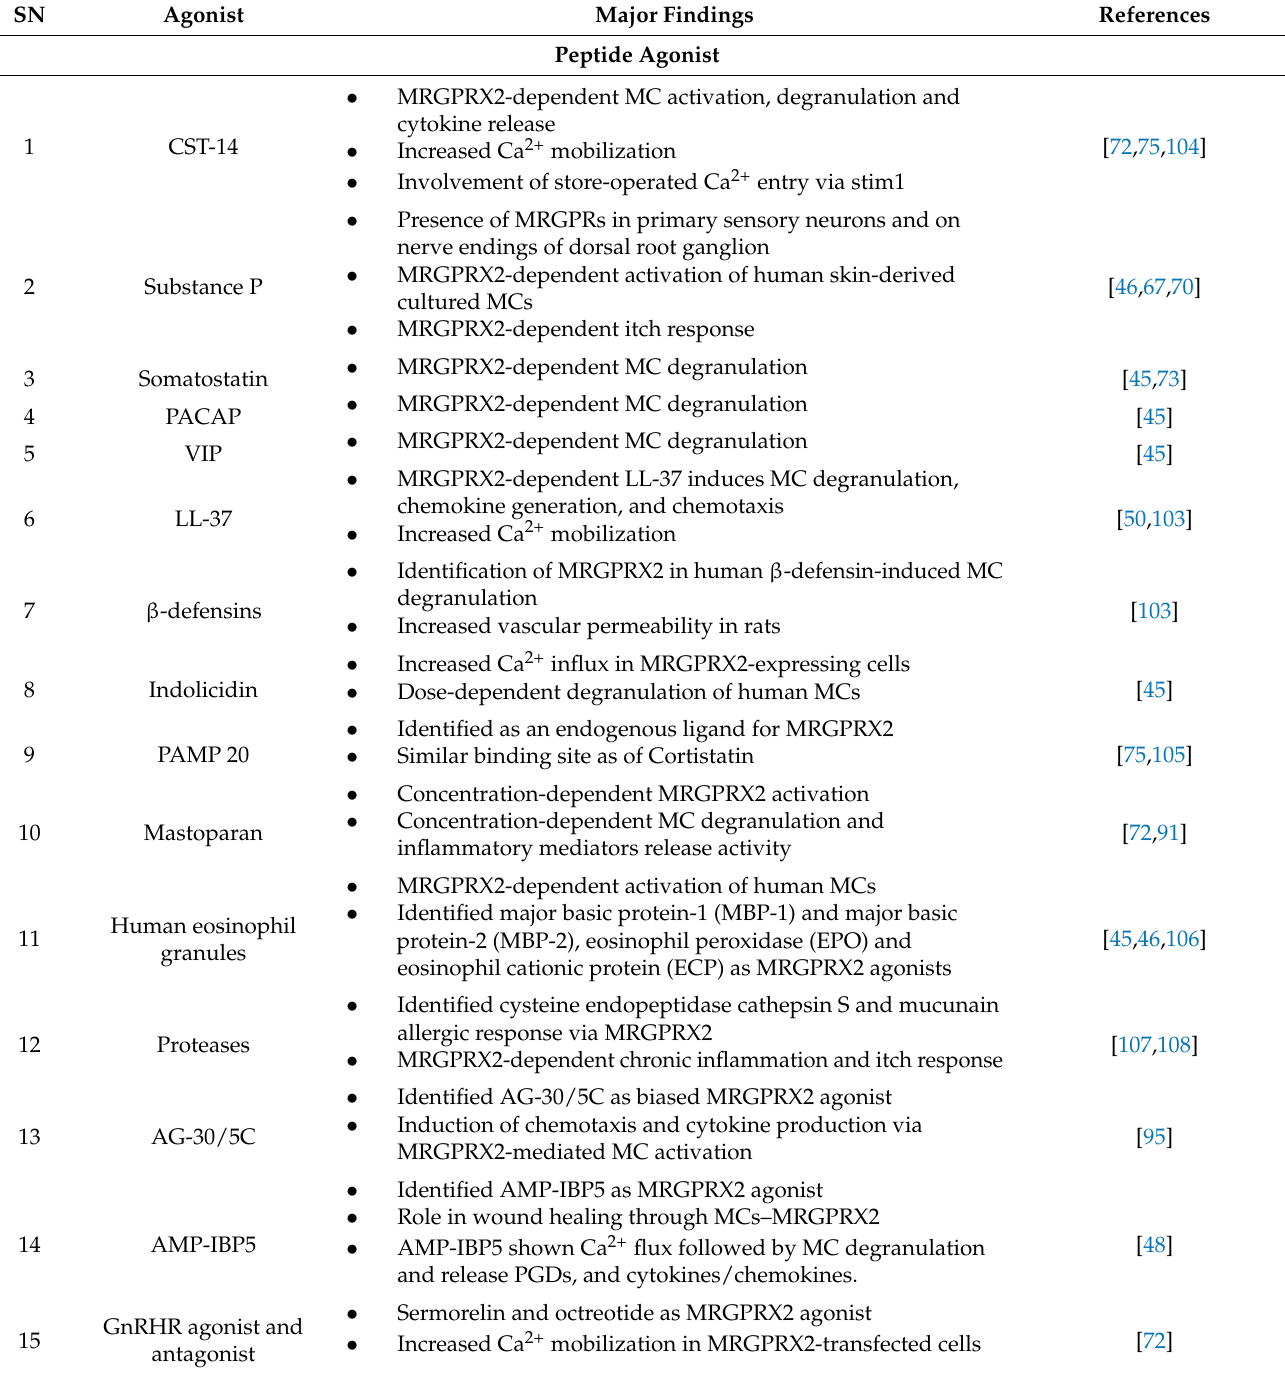
Table 1. Summary of the MRGPRX2/MRGPRB2 agonists (peptides, non-peptides and natural compounds). SN Agonist Major